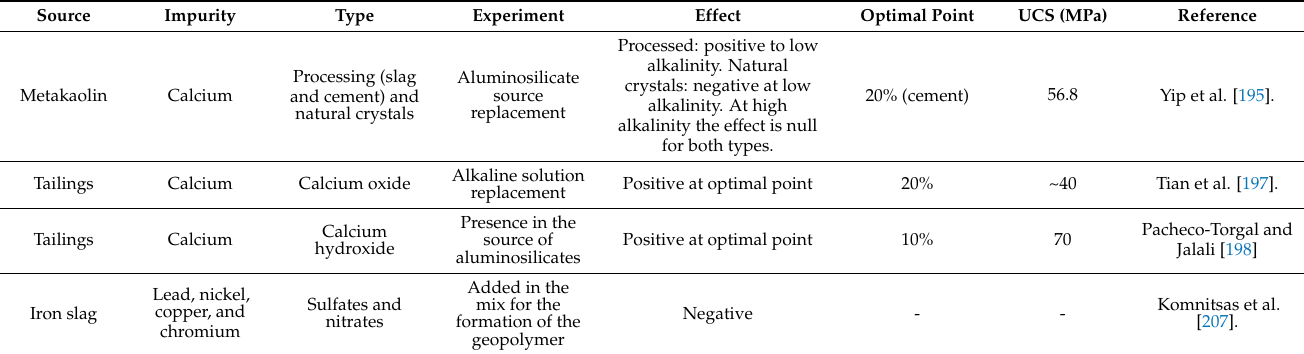
Table 8. Summary on impurities in the formation of